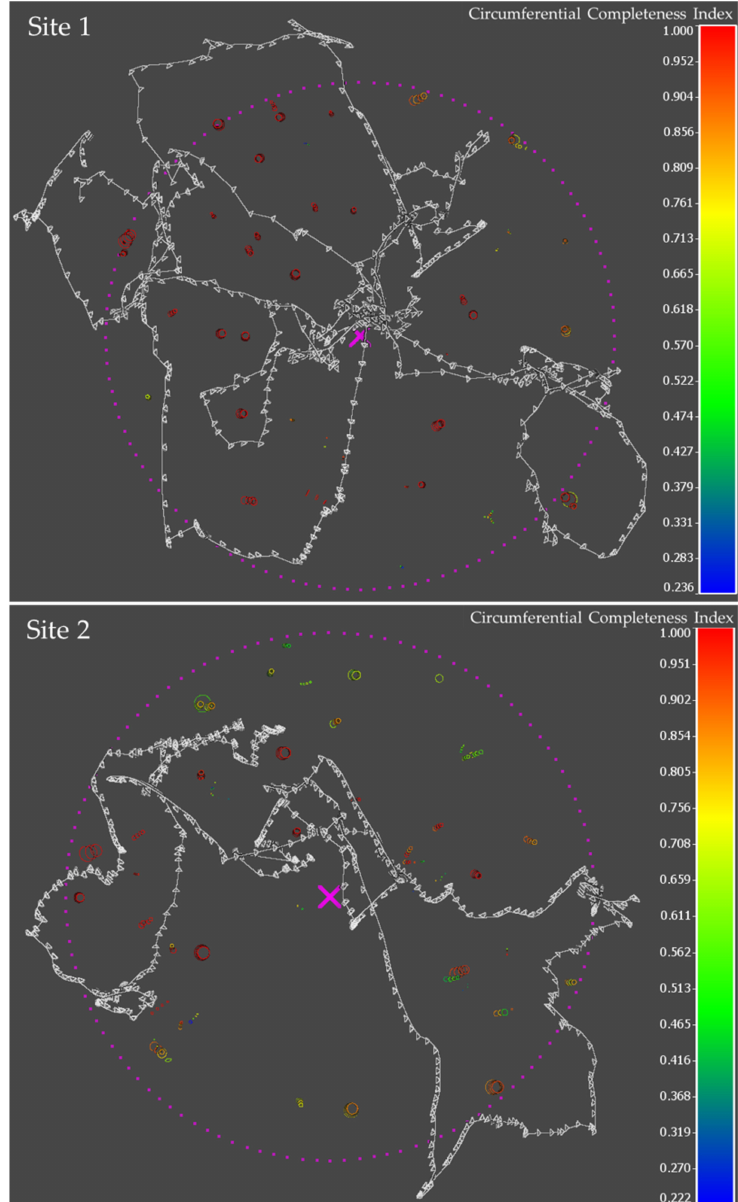
Figure 12. A visualization showing how Circumferential Completeness Index (CCI) is related to the flight path and camera orientation / coverage (shown in white). CCI ranges from 0 to 1; however, measurements with CCI of 0 are not visualized as these were missing point cloud measurements. Small stem sections with bushy vegetation around them are more poorly reconstructed and have a lower CCI than large, vegetation-free stem sections, which were generally better reconstructed. The purple circle of points shows the extents of the 13-m-radius plot circle with the plot center marked by the purple X. The validated mean CCI values were 0.78 for Site 1 and 0.70 for Site 2. The validated and unvalidated median CCI values for Site 1 were 1.0, meaning that greater than half of the point cloud measurements taken had complete circles of points around the tree. The validated median CCI for Site 2 was 0.78 and the unvalidated median CCI was 1.0. Histograms are shown for both sites in Figure 13 to visualize the distribution of CCI under the di ff ering site conditions. A well-mapped section of forest would be skewed to the right in these plots and a poorly mapped region would be skewed to the left. It was expected that Site 2 would be less complete overall due to the dense understory and reduced flyable space, making the mapping process more di ffi cult than in Site